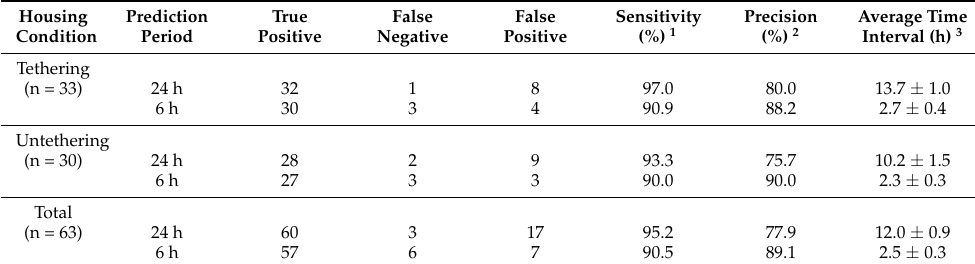
Table 2. Performance of the calving prediction models for predicting 24-h and 6-h periods before calving under tethering and untethering conditions.